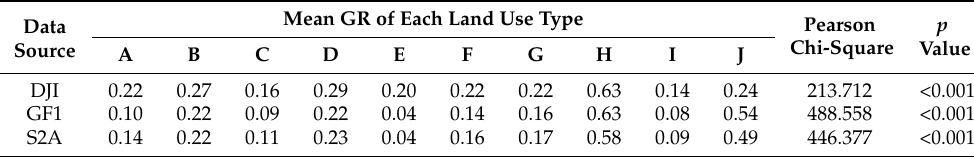
Table 5. The mean GR of each land use type and results of Chi-Square test. Data